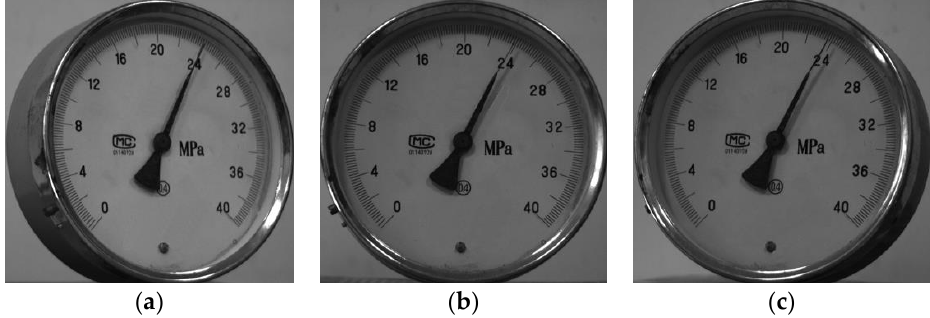
Figure A6. the meter image taken by camera from three angles when the reading of the pointer meter is 23.9; ( a ) the camera at position 1; ( b ) the camera at position 2; ( c ) the camera at position 3.